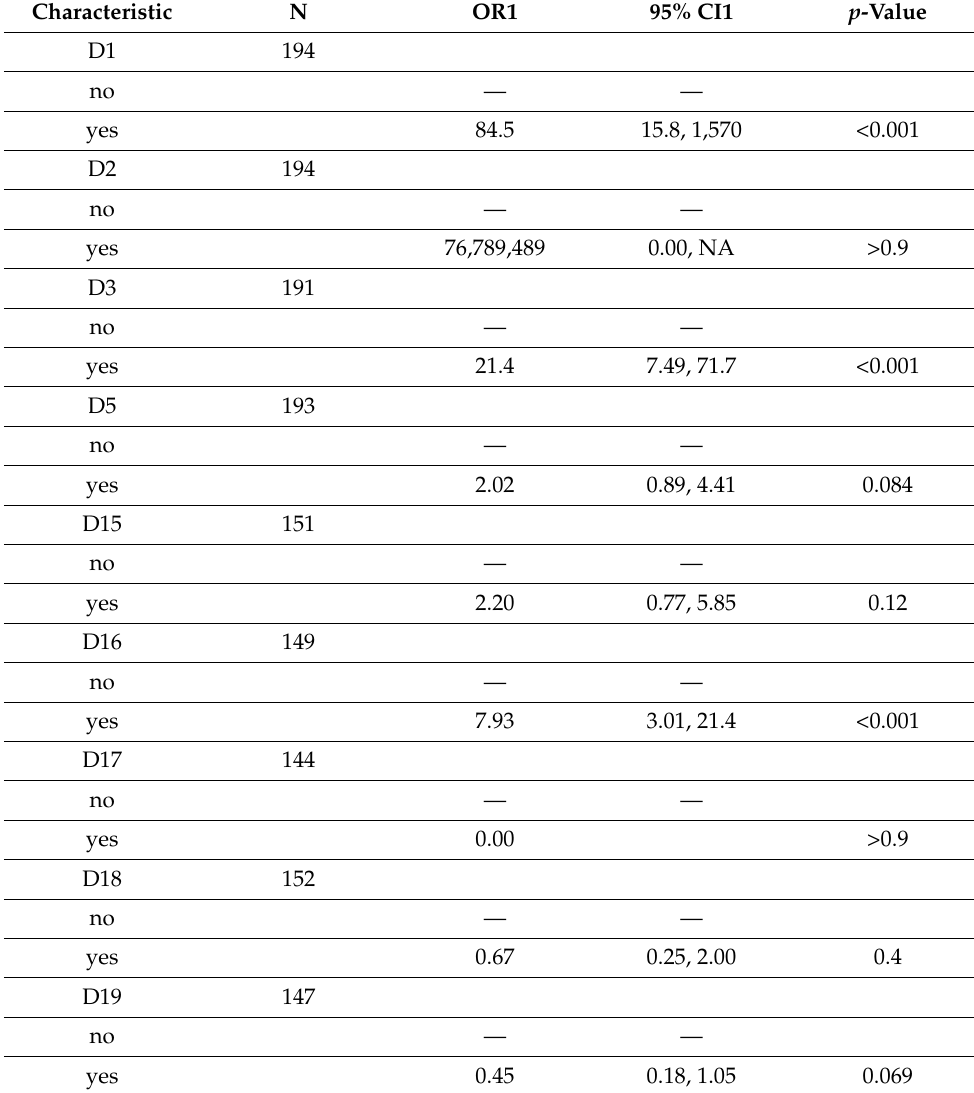
Table 2. Univariate logistic regression results (1OR = Odds Ratio, CI = Confidence Interval). Characteristic